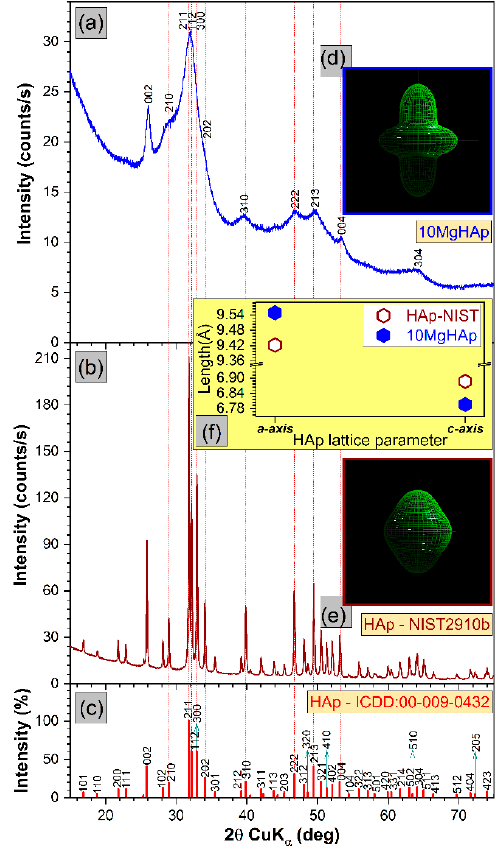
Figure 11. The comparative XRD patterns of the ( a ) 10MgHAp and ( b ) NIST SRM2910-b samples with respect to the ( c ) ICDD-PDF4: 00-009-0432 reference file of hexagonal hydroxyapatite. Crystallite shape as determined by MAUD modelling for ( d ) 10MgHAp and ( e ) NIST SRM2910-b. ( f ) The a -axis and c -axis lattice parameters of the 10MgHAp sample with respect to the ones determined for NIST